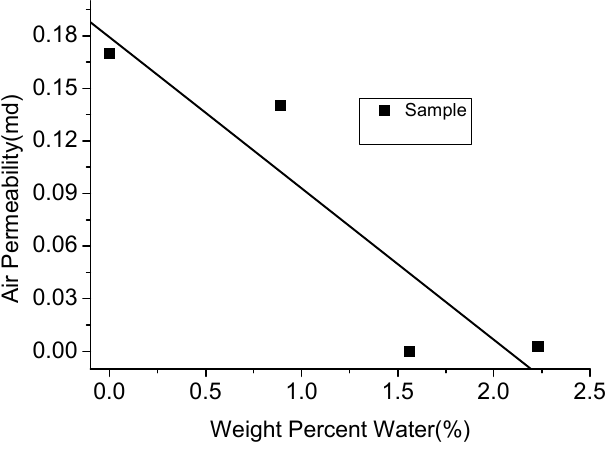
Figure 17. Relationship between air permeability and water content.